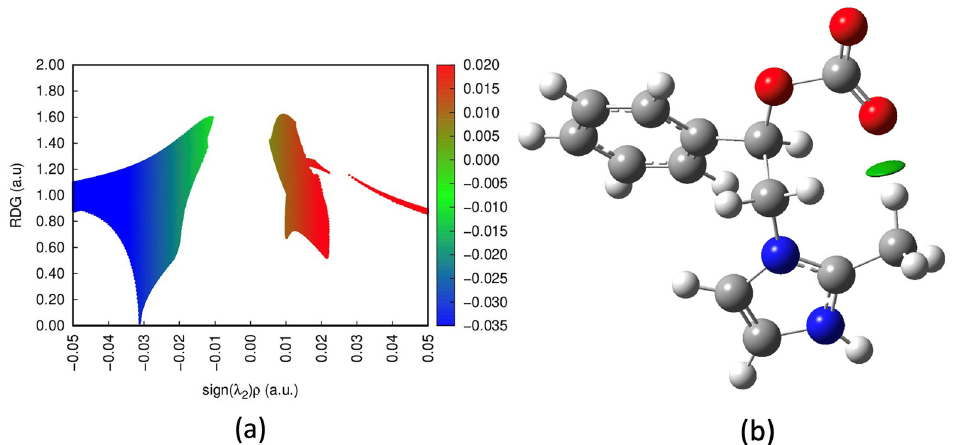
Figure 6. ( a ) The Reduced Density Gradient (RDG) scatter graph representing the NCI of I1 HIm shown in 6b. ( b ) Visual representation of the NCI as a green surface.